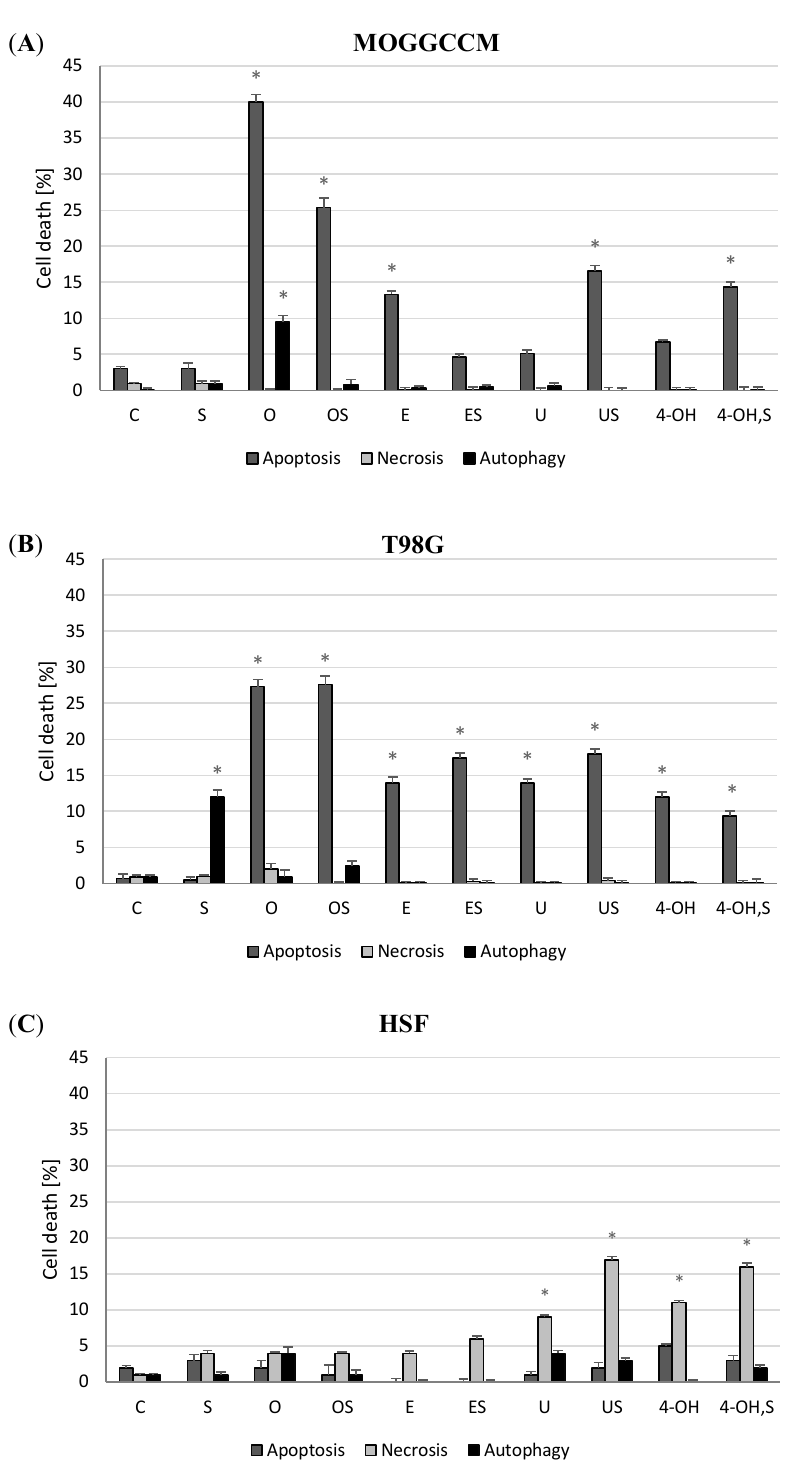
Figure 2. Effect of sorafenib and osthole, esculin, umbelliferone or 4-hydroxycoumarin administered separately or simultaneously on apoptosis, necrosis, and autophagy induction in the MOGGCCM ( A ), T98G ( B ) and HSF (Human Skin Fibroblasts) ( C ) cell lines. C—control, S—sorafenib, O—osthole, E—esculin, U—umbelliferone, 4-hydroxycoumarin; * p < 0.05.